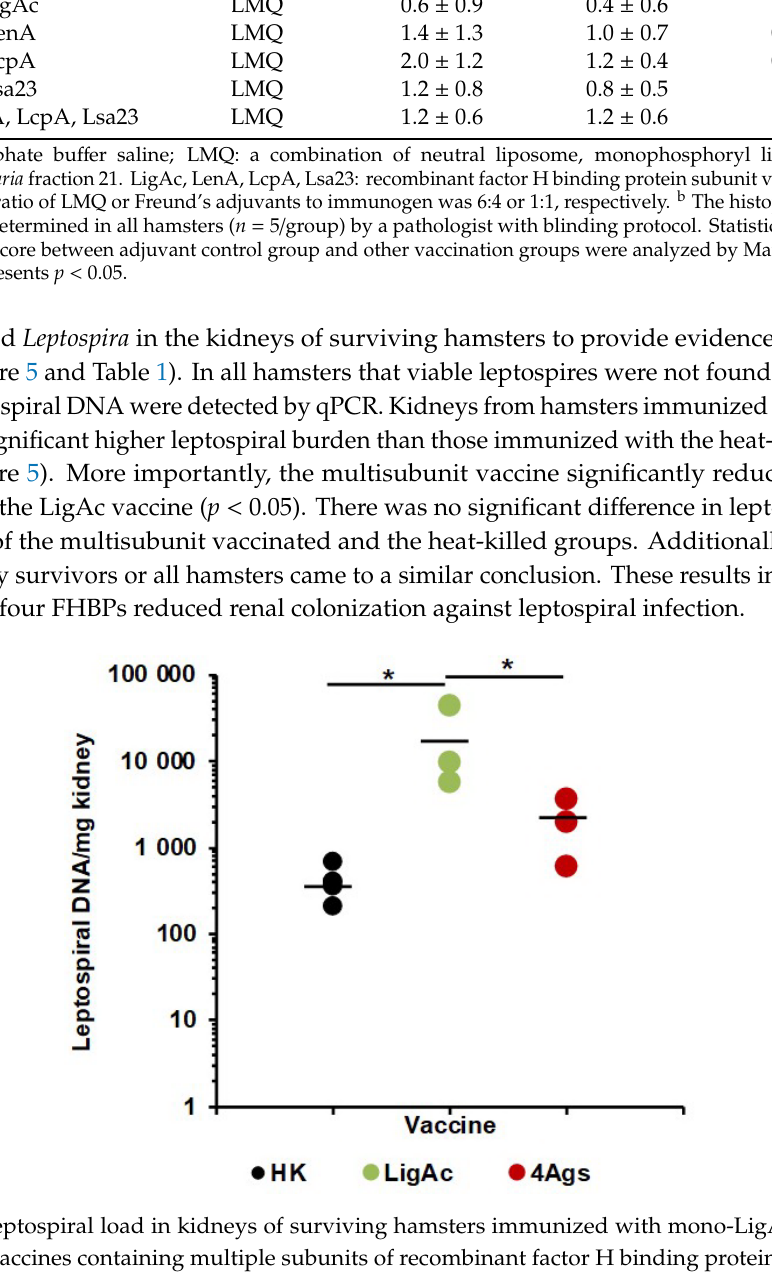
Figure 5 . Leptospiral load in kidneys of surviving hamsters immunized with mono - LigAc subunit vaccine or vaccines containing multiple subunits of recombinant factor H binding proteins (FHBPs) . Total genomic DNA was extracted from kidneys and detected by qPCR . The cycle threshold of each sample was compared with leptospiral DNA standard curve to calculate bacterial burden which is expressed as bacterial DNA per milligram of tissue . The results are shown as mean of each vaccination group; HK = Heat - killed whole cell vaccine; LigAc = LigAc mono recombinant factor H binding protein (FHBP) and LMQ; 4Ags = multiple recombinant FHBPs (LigAc + LenA + LcpA + Lsa23) and LMQ . Only the HK, LigAc, 4Ags groups with at least 3 survivors were used for statistical analysis . Mann – Whitney U test was used to compare bacterial number among vaccination groups; * represents p < 0 . 05 .